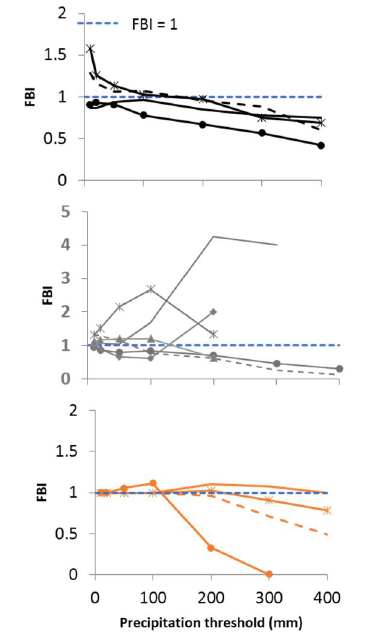
Figure 7. FBI for precipitation thresholds of 10, 20, 50, 100, 200, 300 and 400 mm on the Coastal plains (black), Andean highlands (grey) and Amazonian rainforest (orange). (FBI axis of the Andean highlands is plotted in a different scale)